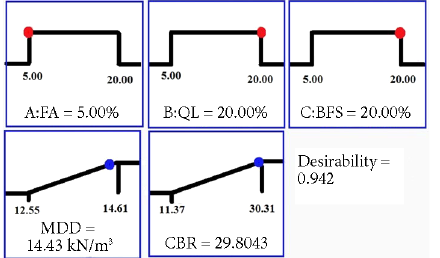
Figure 2. Desirability ramp plot for numerical optimisation